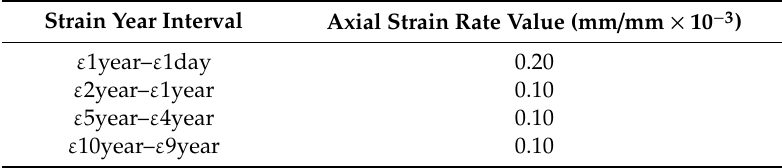
Table 3. Long-term axial strain rate (at the strut adjacent to the hanging point as shown in Figure 4C at four time intervals.